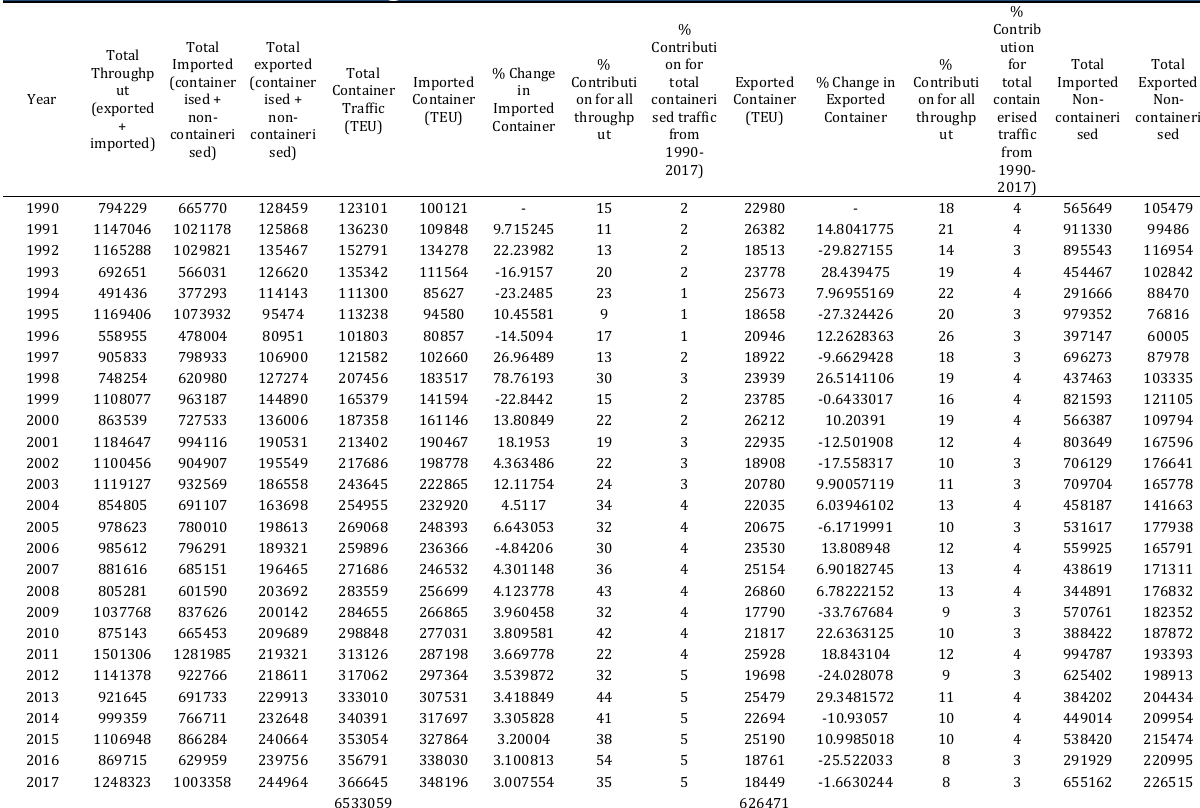
Table 1: Container traffic in Nigeria